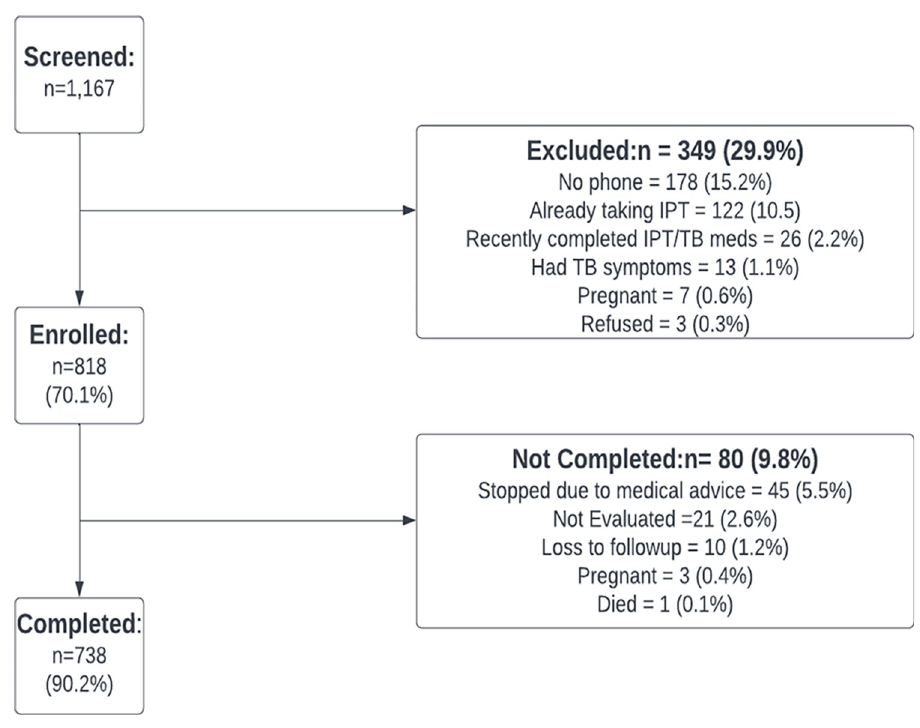
Fig 4. Enrollment flow